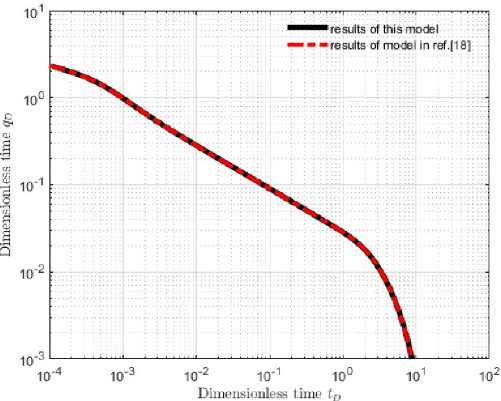
Figure 4. Comparison curve of results between our model and the model [17] in the literature. Table 1. Simulation parameters.